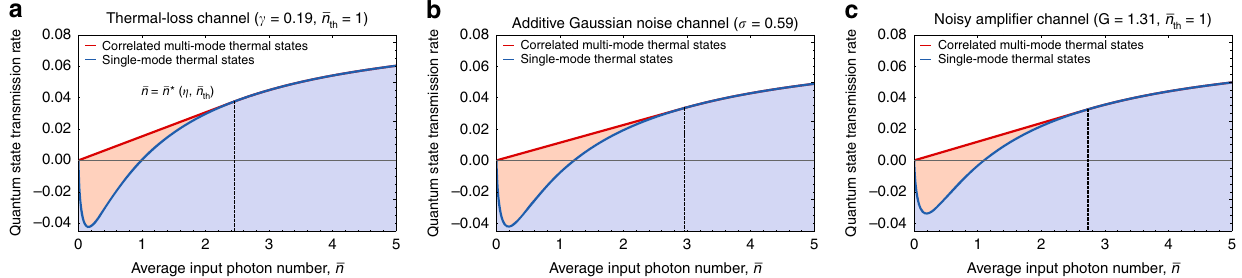
Fig. 3 Convexity of coherent information and superadditivity. Achievable quantum state transmission rate of the single-mode (blue) and correlated multimode (red) thermal states as a function of (cid:2) n for ( a ) the thermal-loss channel N½ η ¼ 0 : 81 ; (cid:2) n 0 : 59 (cid:2) and c the noisy ampli fi er channel A½ G ¼ 1 : 31 ; (cid:2) n corresponds to x ? = 1 ∕ 2.458 = 0.407. This value agrees with x ? = 0.407 which is independently obtained in Fig. 2b for γ = 0.19 and (cid:2) n main number of modes is required if the optimal value of x is a rational number. For example, x ? = 3 ∕ 8 corresponds to the correlated